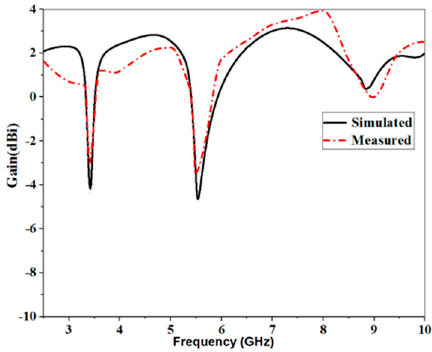
Figure 8. Maximum value of the gain for the antenna.